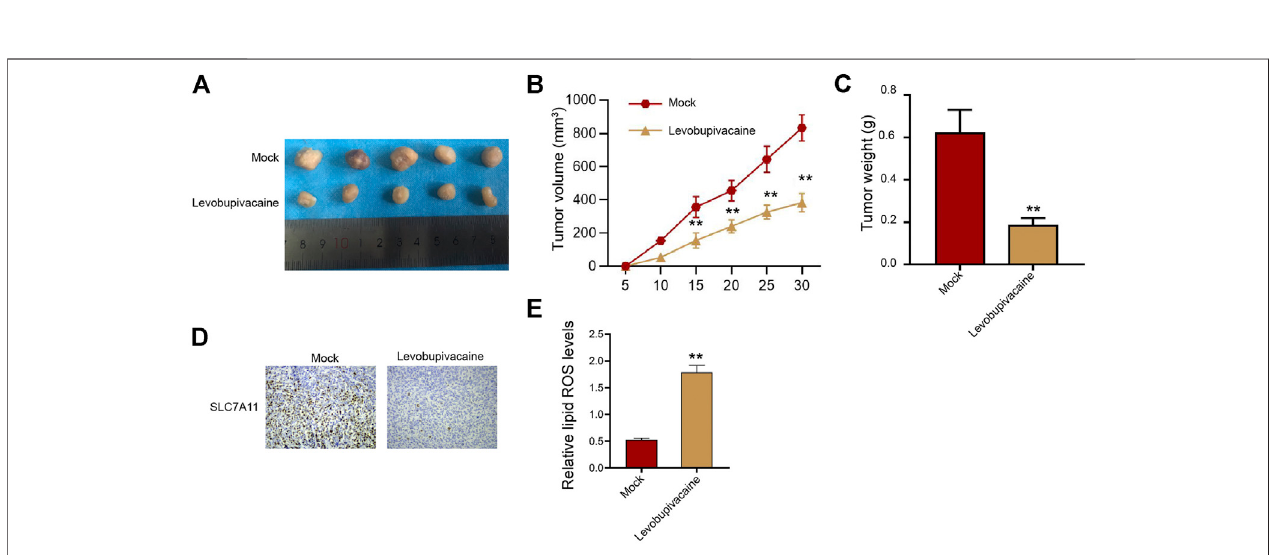
FIGURE 2 | Levobupivacaine represses survival of gastric cancer cells in vivo . (A – E) The mice were injected with SGC7901 cells and treated with levobupivacaine (40 μ mol/kg). The tumor tissues (A) , tumor volume (B) , and tumor weight. (C) were shown. N (cid:2) 5, mean ± SD, ** p < 0.01.